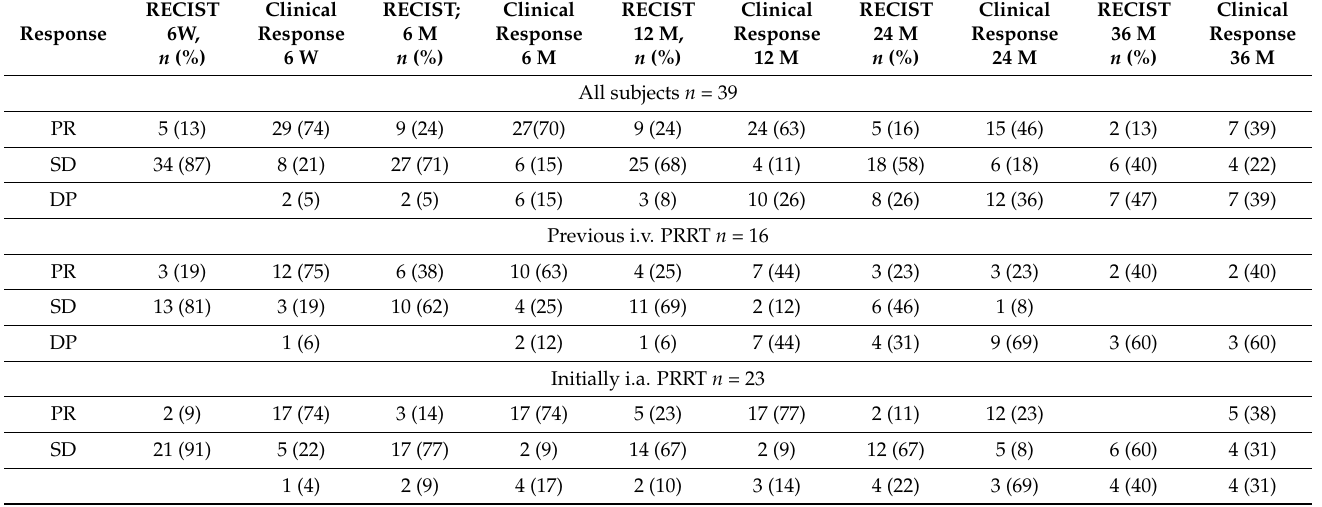
15 patients still alive and imaged at 36 months after PRRT with a DCR of 53%. In those patients who had received both i.v.and i.a. PRRT, the DCR was 60% compared to just 40% in those receiving i.a. PRRT only. There were five patients with a PR at six weeks, but this had increased to nine at six months without further PRRT. At six months, two patients recorded SD. No patient had a CR (Table 4). Table 4. Objective response rate (ORR) and clinical response after six weeks (6 W) and then after six months (6 M), 12 months (12 M), 24 months (24 M), and 36 months of follow-up for all patients after i.a.PRRT ( n = 39). Additional data sets in selected populations of patients after previous i.v. PRRT and in those with initially i.a. PRRT.